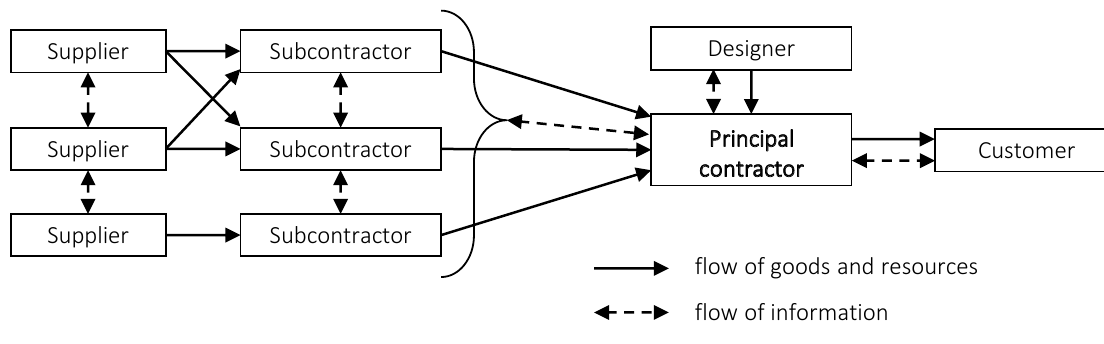
Figure 2. Model of entrepreneurial management of the project supply